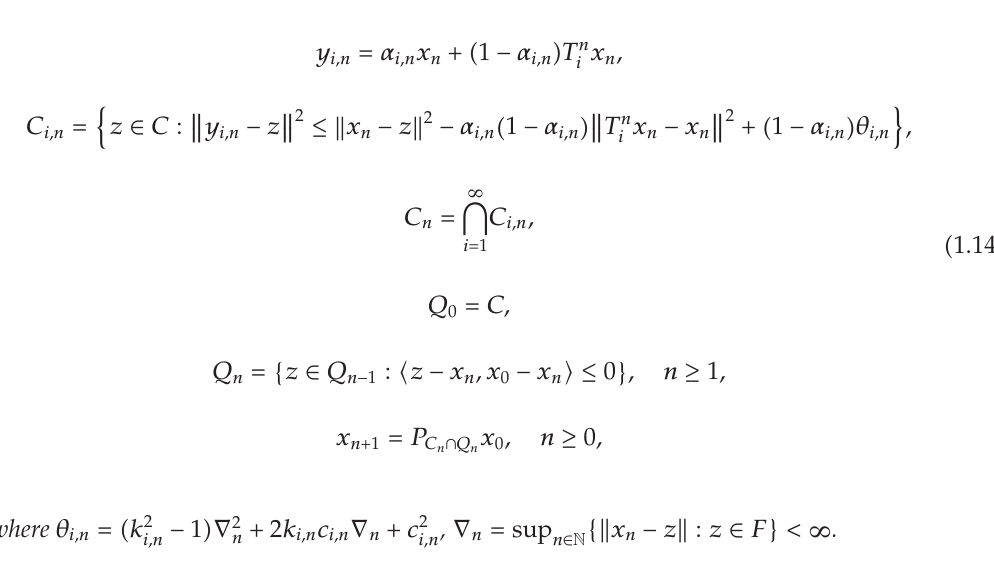
Algorithm 1.3. For an initial point x 0 ∈ C , compute the sequence { x n } by the iterative